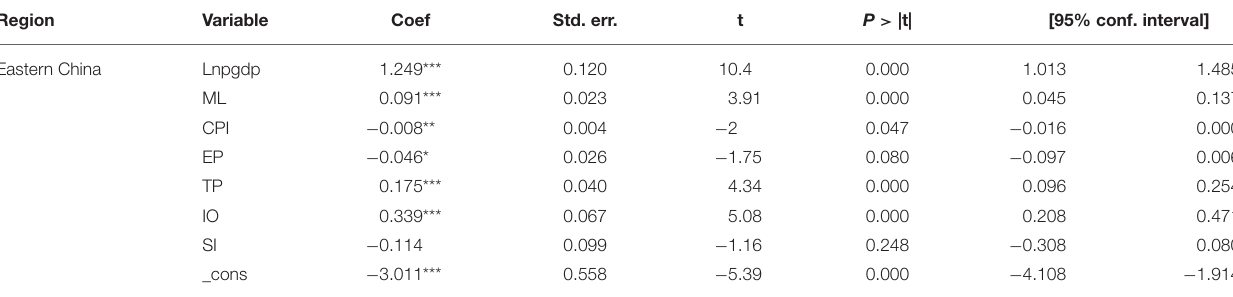
TABLE 6 | Regression of fixed effect of panel data in Eastern China. Region